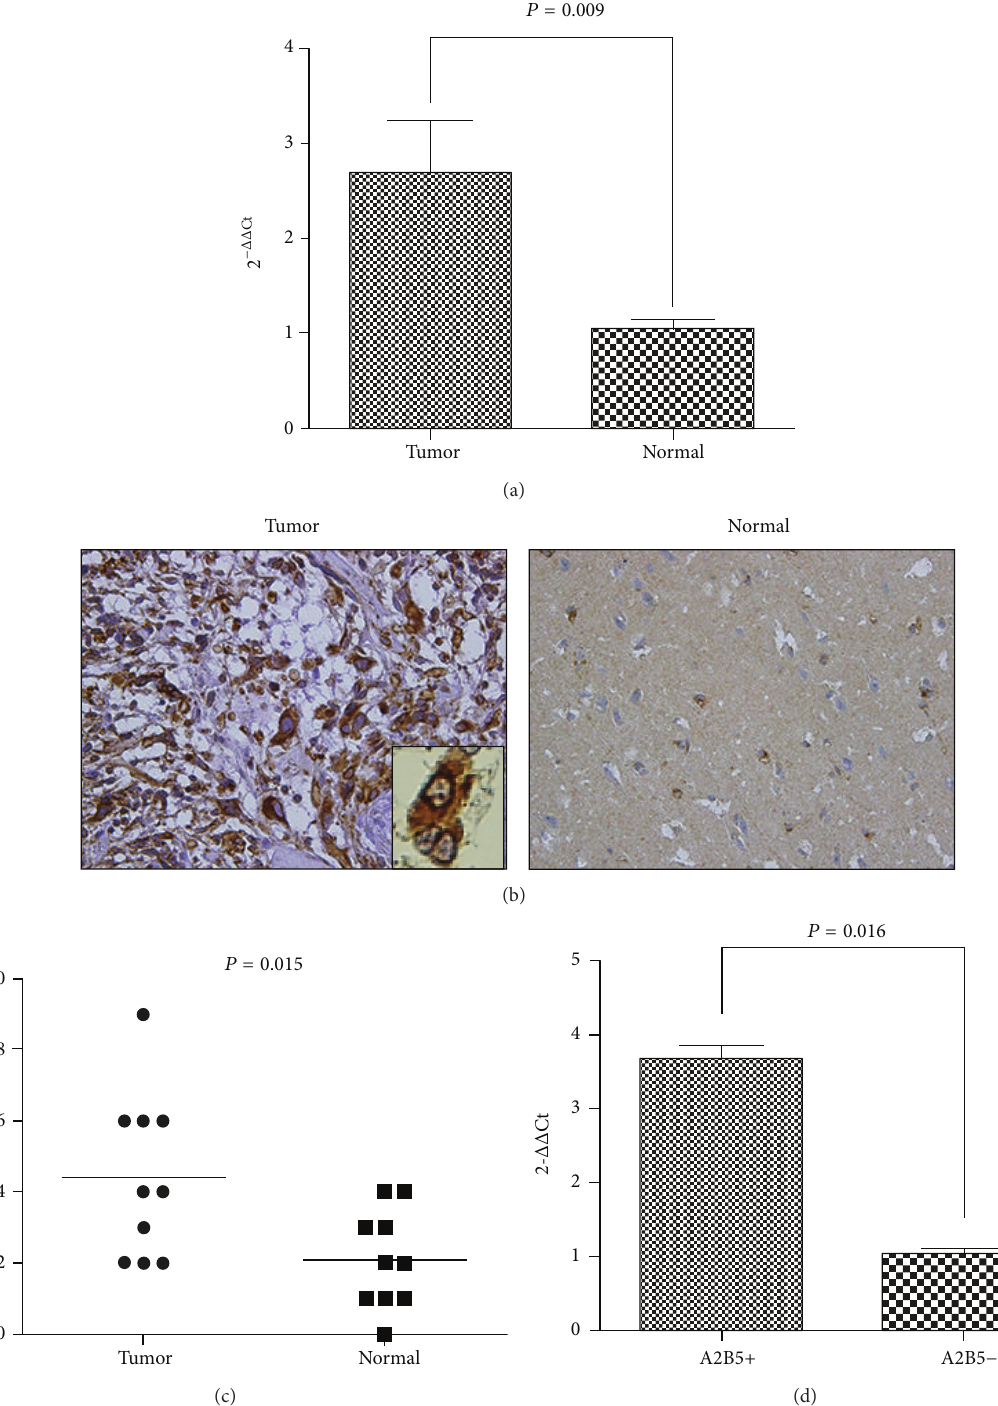
Figure1:HEATR1wasoverexpressedinGBMandinA2B5+GSCs.(a)qRT-PCRwasperformedtoanalyzethedifferentialexpressionbetween GBM tissues ( 𝑛 = 22 ) and controlled brain tissues ( 𝑛 = 8 ). (b)-(c) IHC was performed in FFPE tissue sections of 10 primary GBM tissues (left, × 400) and 10 normal brain tissues (right, × 400). GBM tissues had higher staining score of HEATR1 protein than normal brain tissues ( 𝑃 = 0.015 ). (d) qRT-PCR was performed to analyze the differential expression between A2B5+U87 cells and A2B5 − U87 cells ( 𝑃 = 0.0016